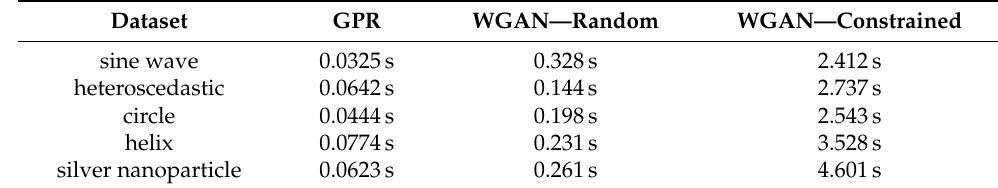
Table 5. First column contains the type of dataset, second column contains how long randomly sampling 4000 of the posterior of the GPR took in seconds, third column contains how long it took to randomly sample 4000 points of the latent space of the WGAN took in seconds and fourth column is how long the WGAN took to run the prediction Algorithm 1 for 1000